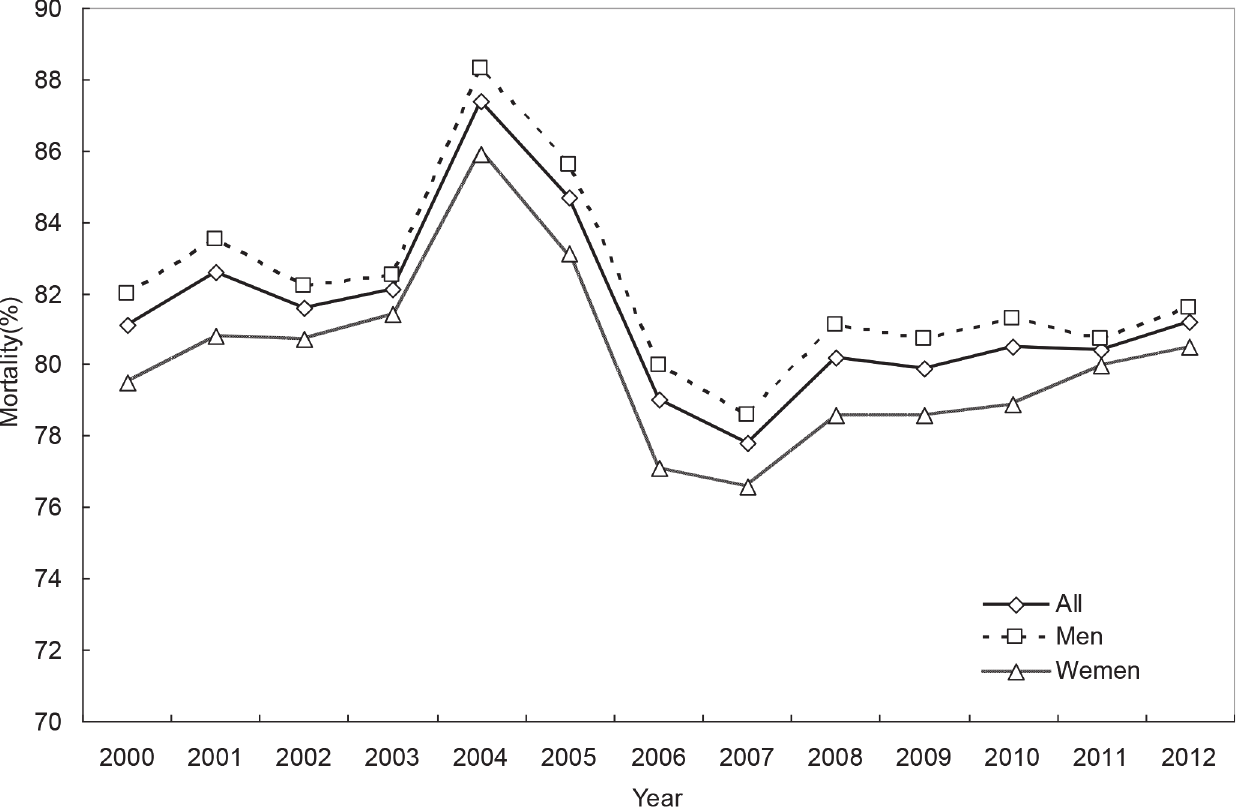
Fig 6. 1-day mortality rates of out-of-hospital cardiac arrest, for both genders combined and by